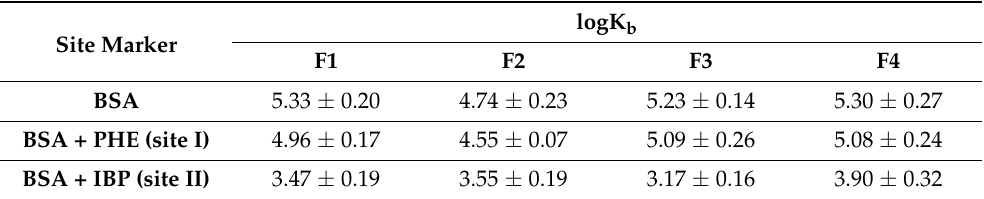
Table 4. The binding constants of the studied compounds with BSA in the presence of site markers: phenylbutazone (PHB) and ibuprofen (IBP) at 297